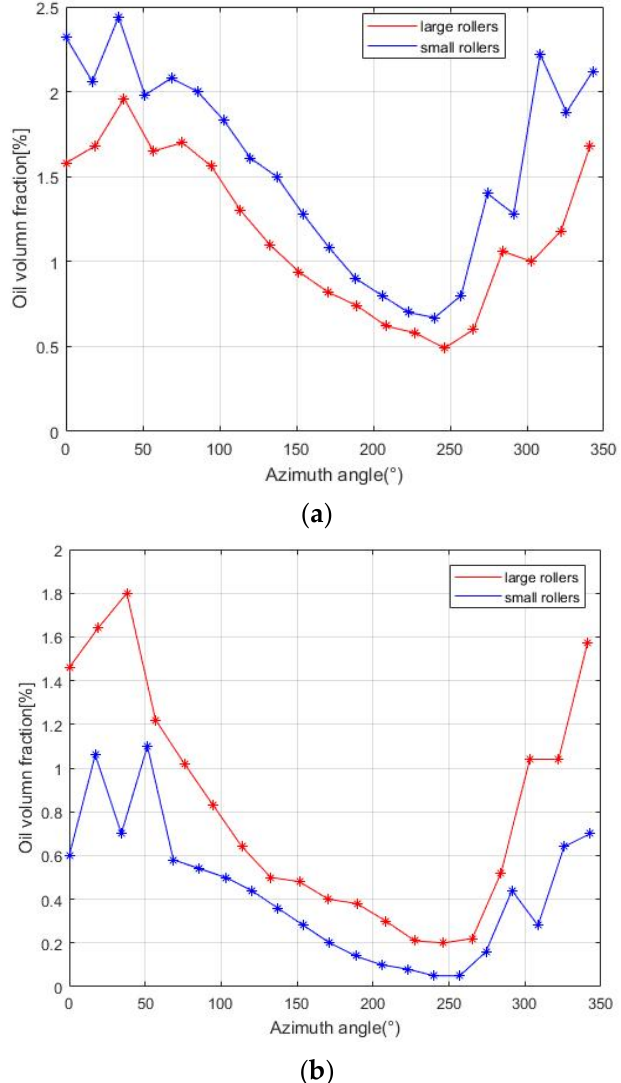
Figure 13. Oil distributions on the walls of large and small rollers. ( a ) Outer ring rib structure; ( b ) Inner ring rib structure.